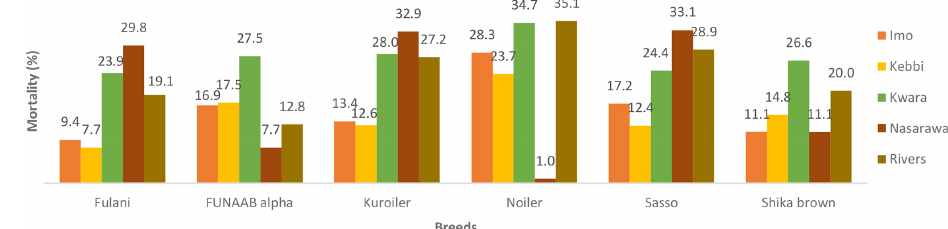
Figure 1. Actual mortality of male birds during growing phase in ACGG project zones (6–18 weeks) (2016–2017).